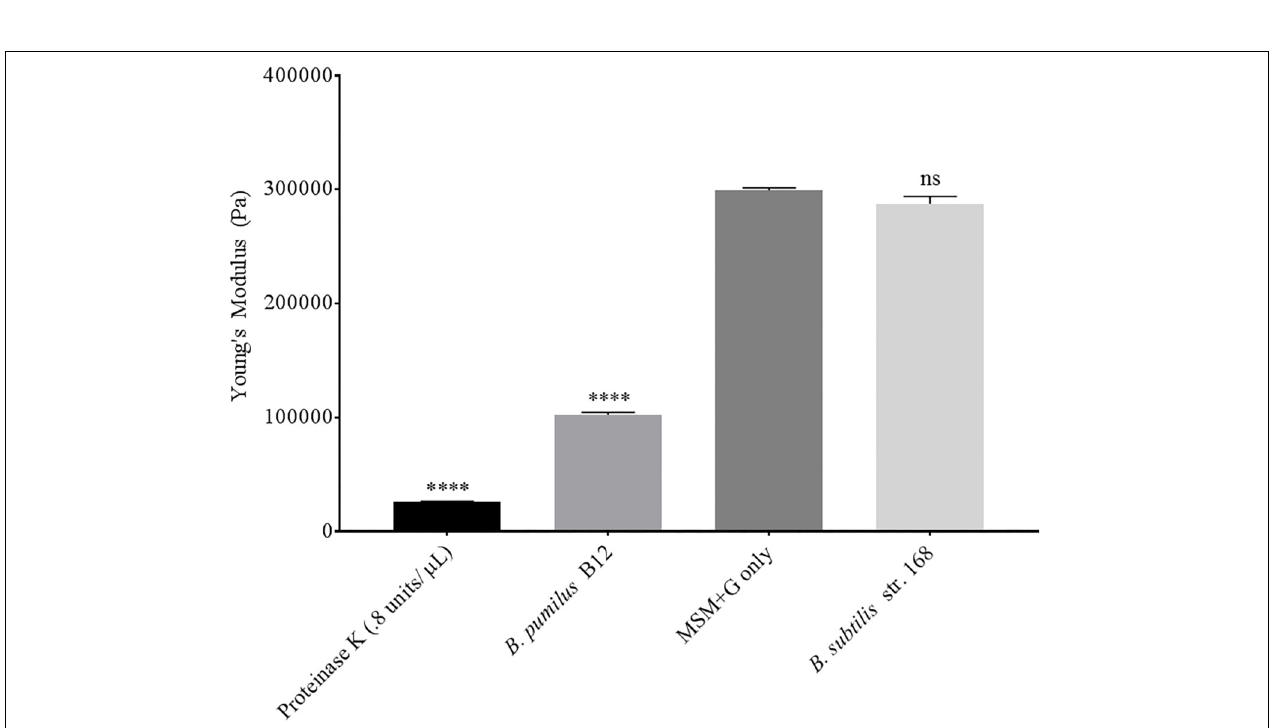
FIGURE 5 | PLA films show a decrease in elastic strength when incubated with B. pumilus B12. Shows the average of all cantilever measurements taken over 3 biological replicates. Elastic strength is measured in Young’s modulus Pascals (Pa). All samples were incubated in MSM + glucose for 48 h. B. subtilis str.168 (NC_000964.3) was used as a negative control. ∗∗∗∗ indicates ANOVA p -value ≤ 0.0001 and ns indicates ANOVA p -value ≥ 0.05 compared to MSM plus glucose (MSM + G) control. These assays were performed with three biological and three technical replicates.